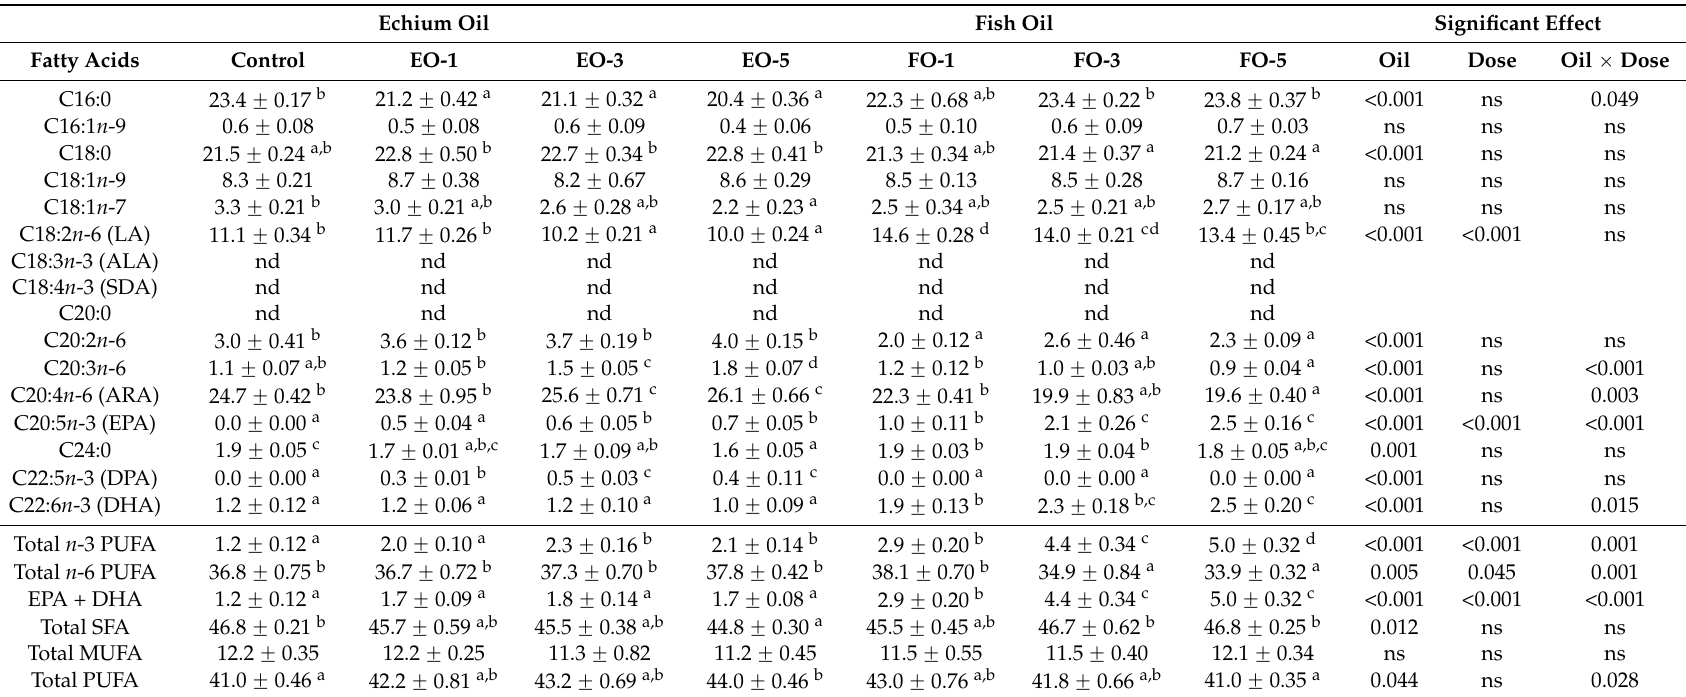
Table 5. Kidney phospholipid fatty acid composition in rats fed diets supplemented with Echium oil or Fish